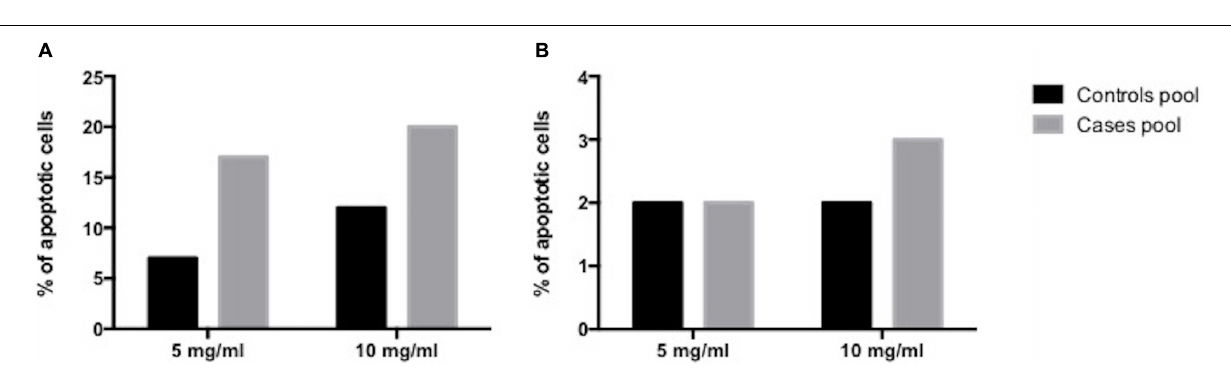
FIGURE 2 | FasL and TRAIL quantification in VE. (A) Quantification of FasL in VE (controls vs. EO-PE p = 0,0379; controls vs. LO-PE p = 0,2564; EO-PE vs. LO-PE: p = 0,6031). (B) FasL/VE ratio (controls vs. EO-PE p = 0,0262; controls vs. LO-PE p = 0,0379; EO-PE vs. LO-PE: p = 0,0262). (C) Quantification of TRAIL in VE (controls vs. EO-PE p = 0,6894; controls vs. LO-PE p = 0,7791; EO-PE vs. LO-PE: p = 0,6894). (D) TRAIL/VE ratio (controls vs. EO-PE p = 0,0379; controls vs. LO-PE p = 0,9656; EO-PE vs. LO-PE: p = 0,0379). * p ≤ 0,05.